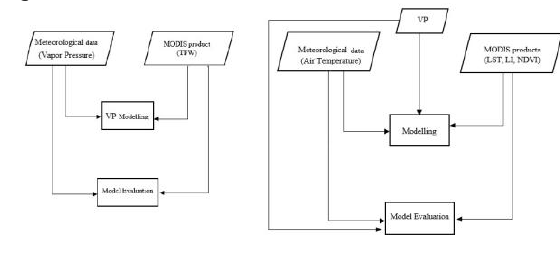
Figure2. Research